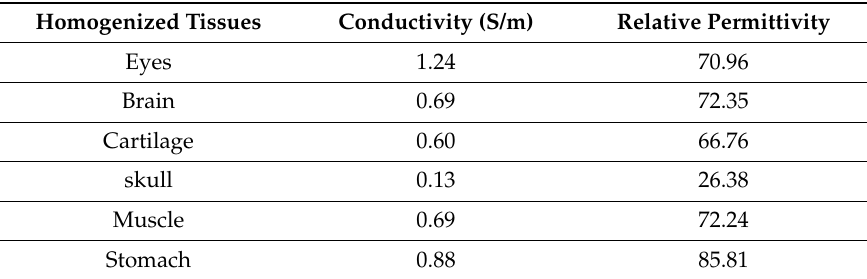
Table 2. Dielectric properties for the homogenized tissues of the individual models.